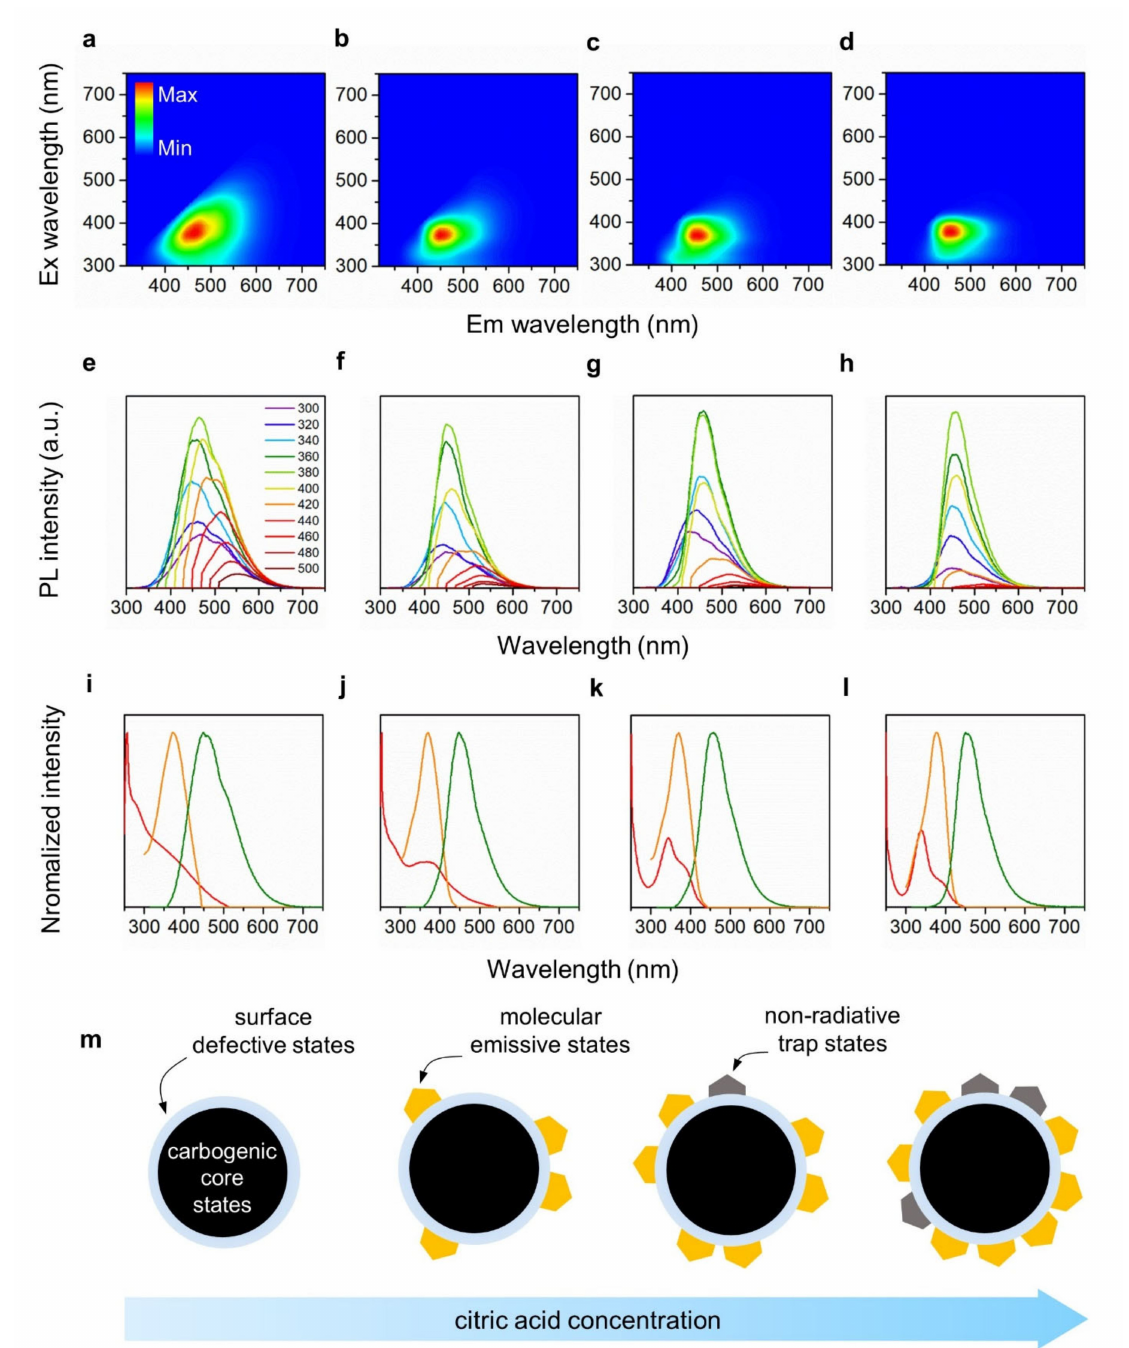
Figure 3. PL emission maps and spectra for excitation wavelengths of 300–600 nm. Emission maps: ( a ) CND1, ( b ) CND2, ( c ) CND3, and ( d ) CND4. Emission spectra: ( e ) CND1, ( f ) CND2, ( g ) CND3, and ( h ) CND4. Absorption (red), excitation (orange), and emission (green) spectra: ( i ) CND1, ( j ) CND2, ( k ) CND3, and ( l ) CND4. ( m ) Schematic illustration of the change in chemical structure with increase in the concentration of citric